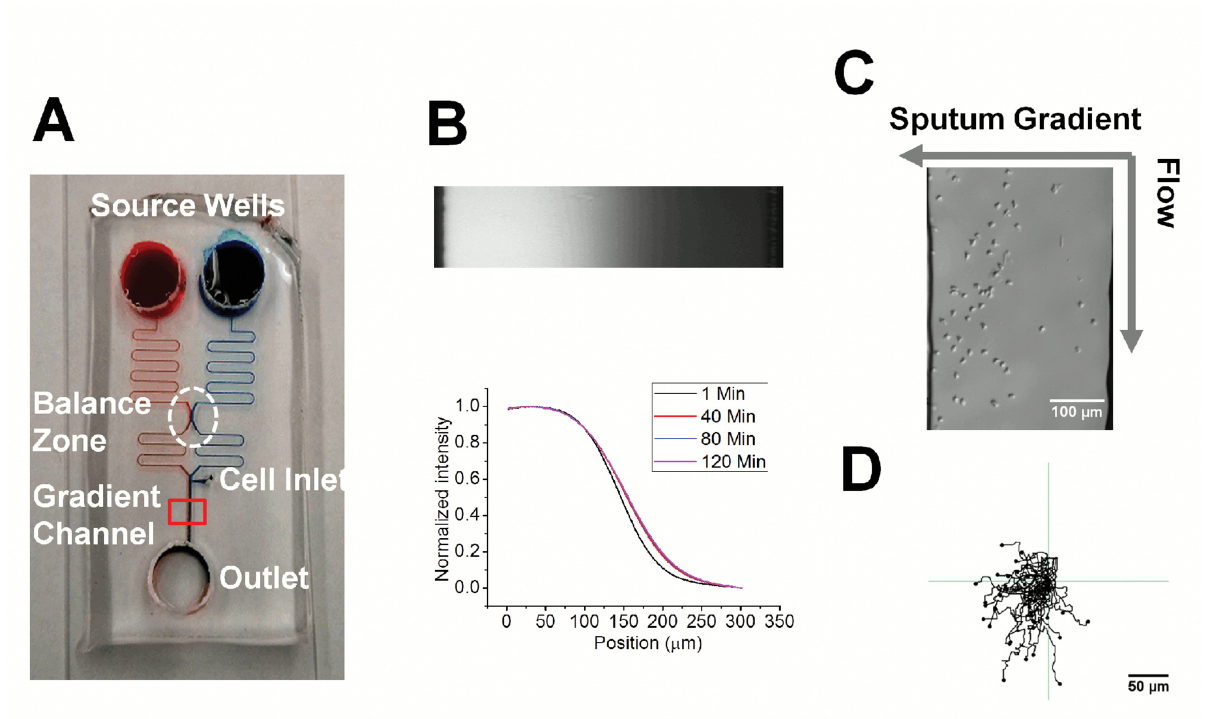
Fig 1. Illustration of the microfluidic device for testing neutrophil chemotaxis. (A) Illustration of the microfluidic gradient generator with a pressure balance zone. Red and blue dyes were injected into the device for visualization of the channels; (B) The fluorescent image of the FITC-Dextran gradient in the mirofluidic channel and the corresponding gradient profiles at different time points; (C) A representative image of neutrophils in a COPD sputum gradient in the microfluidic channel at the end of the 20min migration experiment; (D) The corresponding cell tracks for the experiment in (C) .